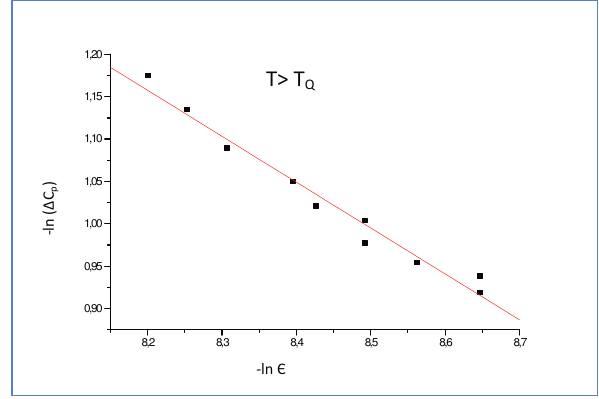
Figure 8. The specific heat (cid:3)C P as a function of the re- duced temperature ( (cid:4) D j T (cid:2) T Q j =T Q / above the transi- tion temperature ( T Q D 577:1 ı C) for the ˛ - ˇ transition in quartz according to Eq. (2). The specific heat C P data [2] was analyzed along the cooling curve (see Table